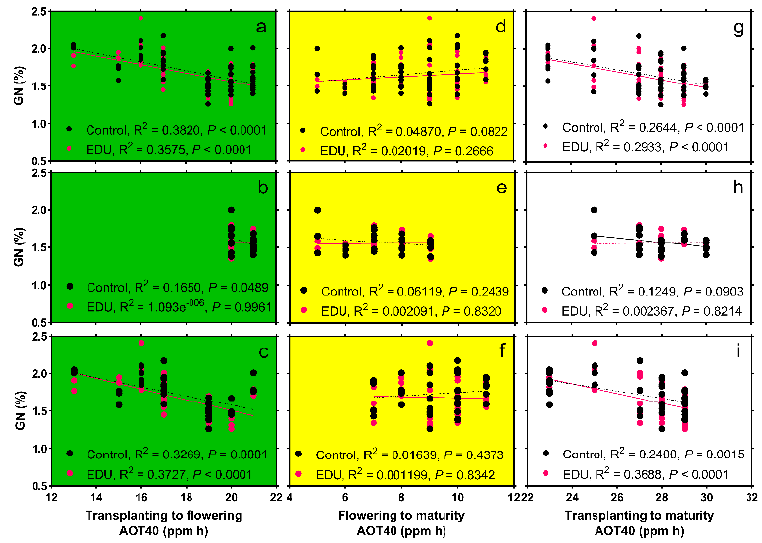
Figure 4. Grain nitrogen (GN) plotted against AOT40 at different growth stages (( a ), transplanting to flowering; ( d ), flowering to maturity; ( g ), transplanting to maturity) in rice cultivars and separate sensitivities for hybrid ( b , e , h ) and inbred cultivars ( c , f , i ). Solid and dashed lines indicate simple linear regressions between GN and AOT40.